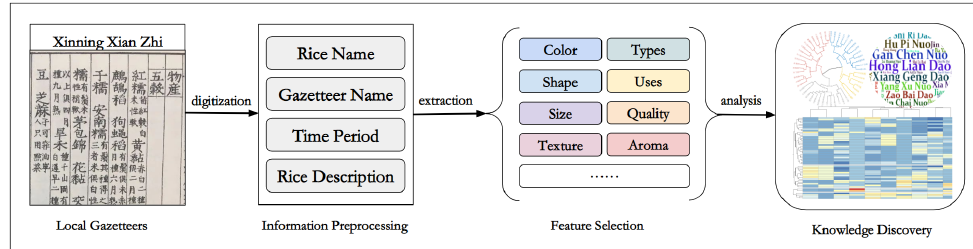
Figure 1. A general overview of our